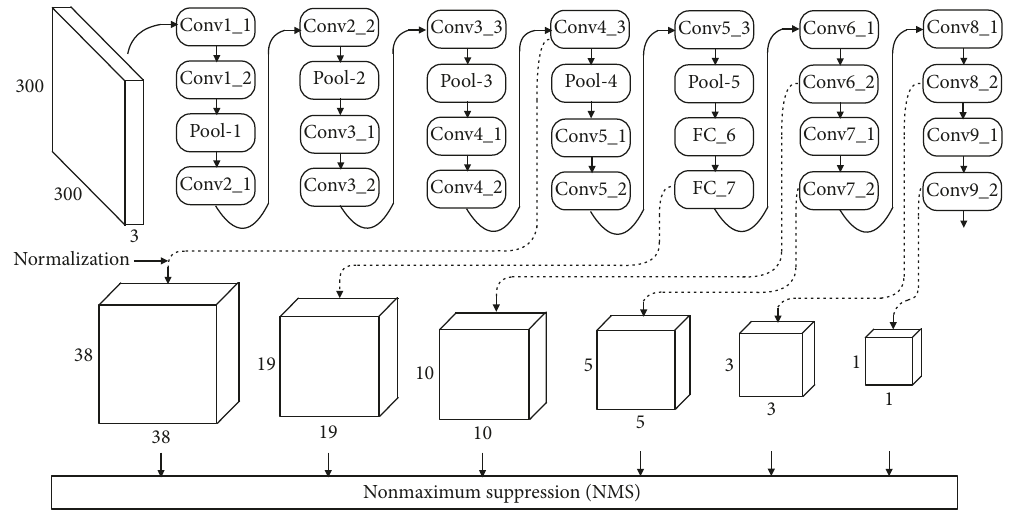
Figure 1: Schematic diagram of the SSD